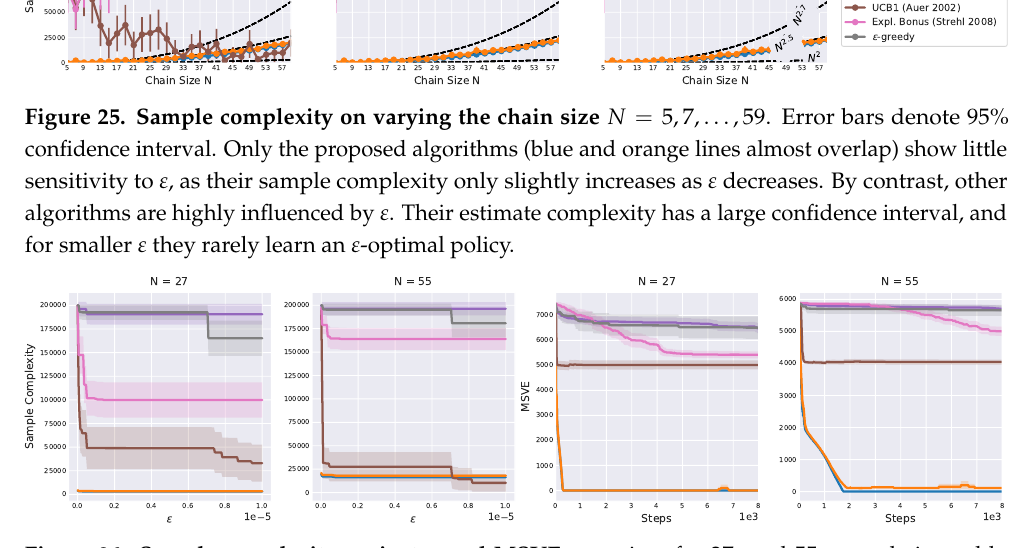
Figure 26. Sample complexity against ε , and MSVE over time for 27- and 55-state chainworlds. Shaded areas denote 95% confidence interval. As shown in Figure 25, the sample complexity of our approach is barely influenced by ε . Even for ε = 0, our algorithms attain low sample complexity, whereas other algorithms complexity is several orders of magnitude higher. Similarly, only our algorithms learn an almost perfect Q-function, achieving an MSVE close to